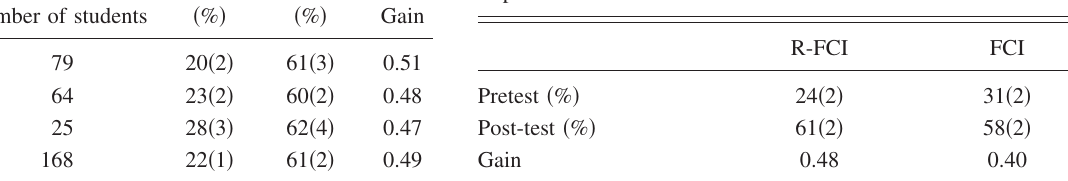
TABLE III. Percentages of pre- and post-R-FCI raw score re- sults and students’ average normalized gain. Standard errors are in parentheses. TABLE IV. Students’ (cid:1) n =87 (cid:2) pre- and post-test raw scores and average normalized gains of the R-FCI and FCI. Standard errors are in